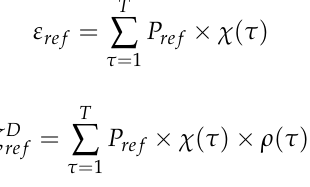
Table 11. Refrigerator Simulation